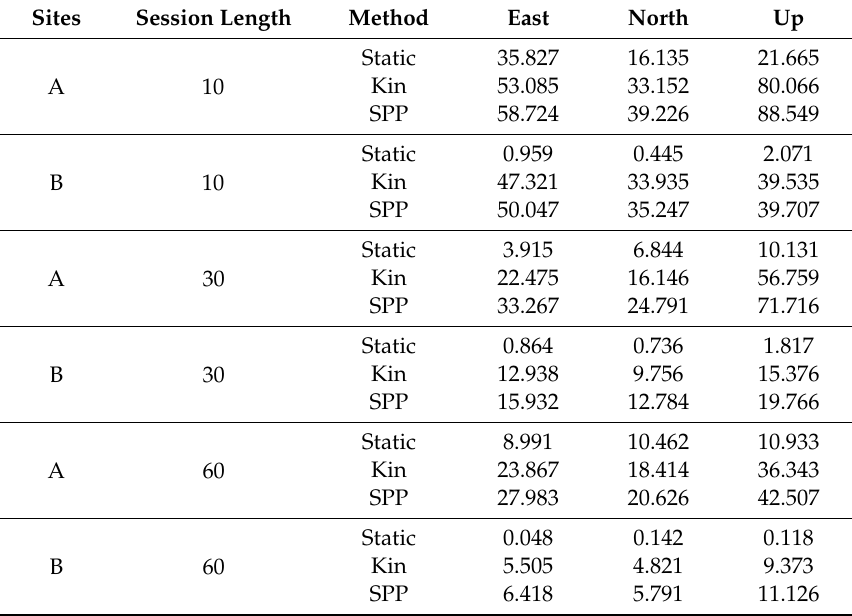
Table 2. Precision of the positioning results using Huawei P10 + in